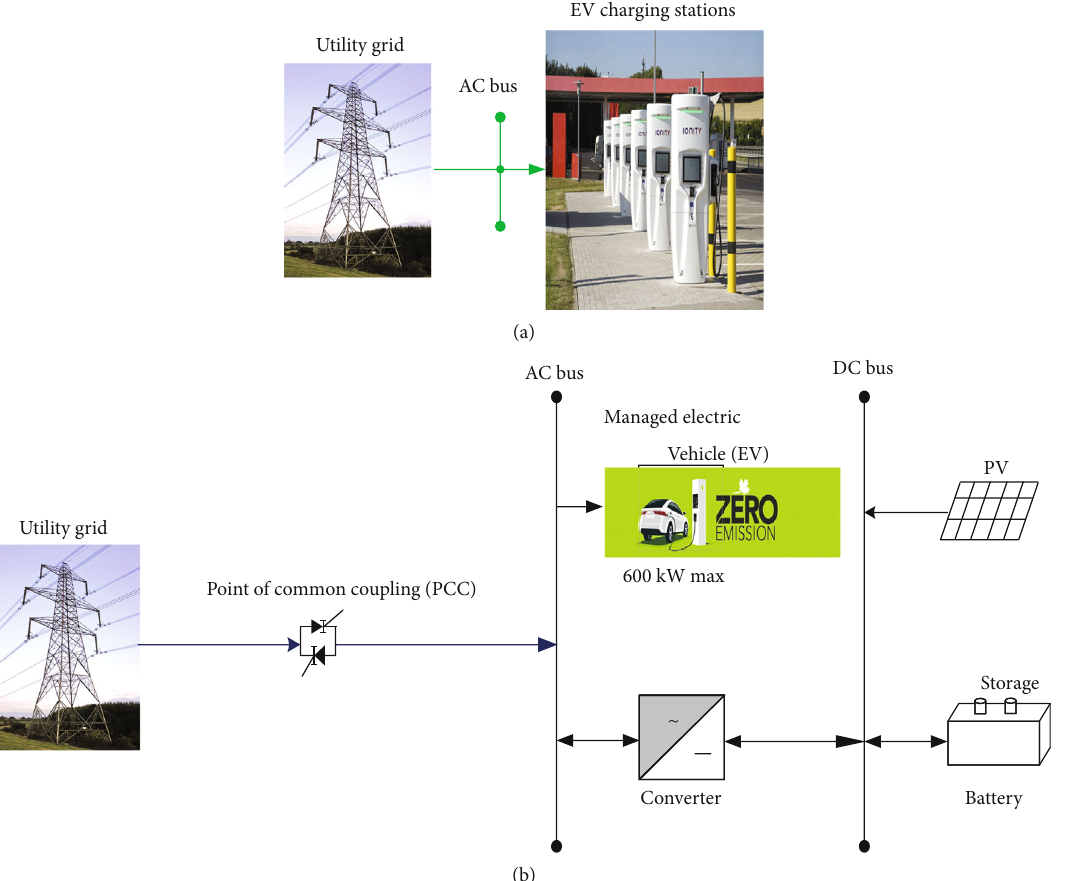
Figure 5: The proposed system (a) and the current system (b).